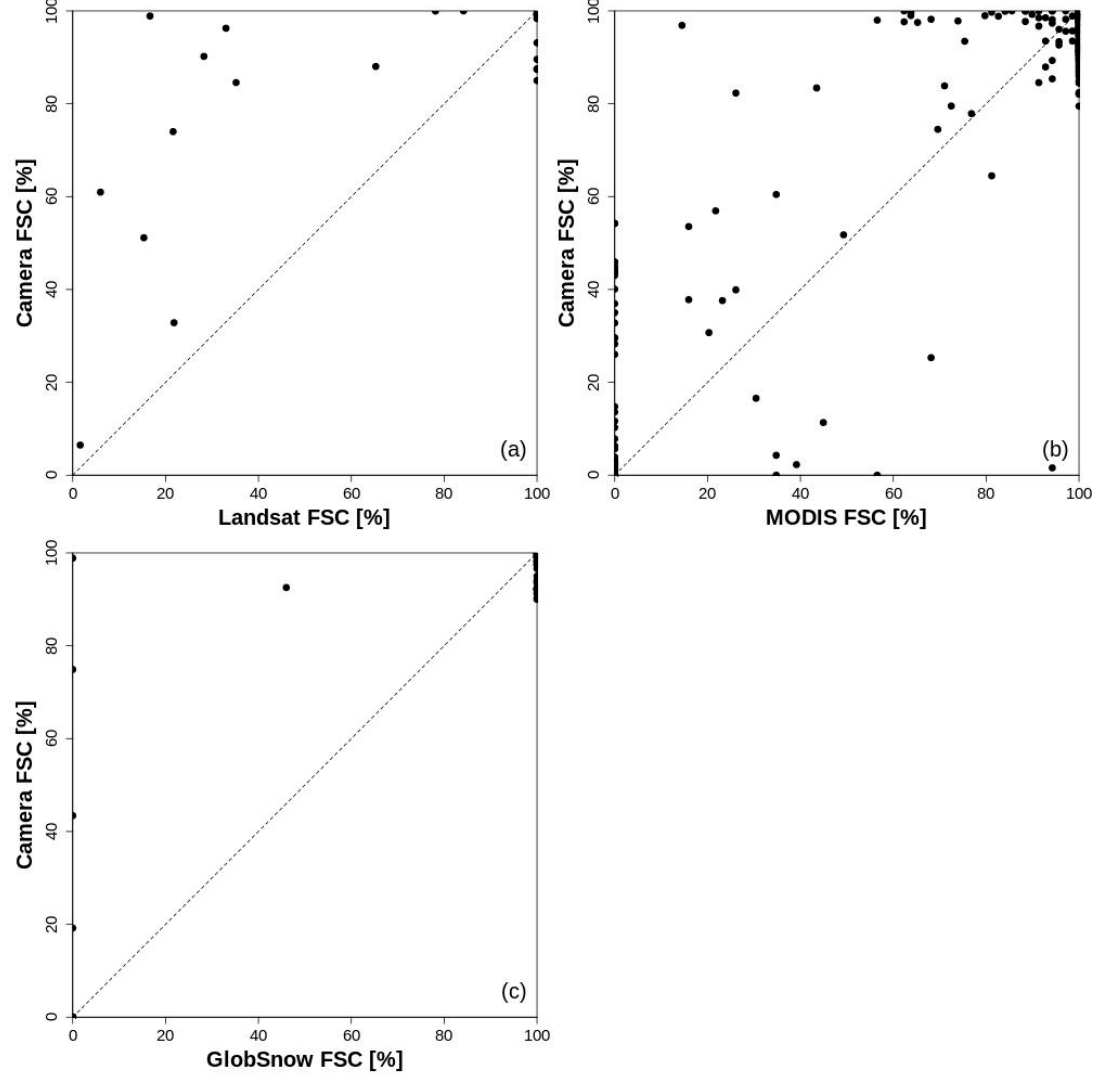
Figure 5. Comparison between Fractional Snow Cover estimations obtained by terrestrial photography and remote sensing. Plots refer to Landsat ( a ), MODIS ( b ) and GlobSnow ( c ).